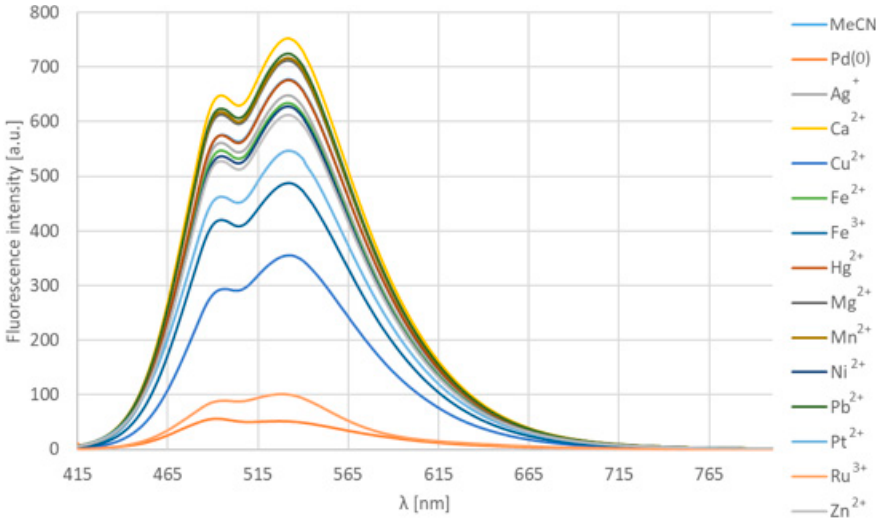
Figure 9. The emission spectra of 12d in the presence of 100 equivalents of metals and different cations in acetonitrile at room temperature after 5 min.